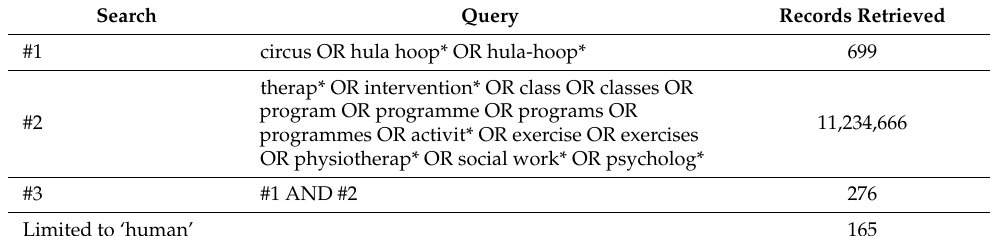
Table A2. Example of search strategy in MEDLINE (Ovid).